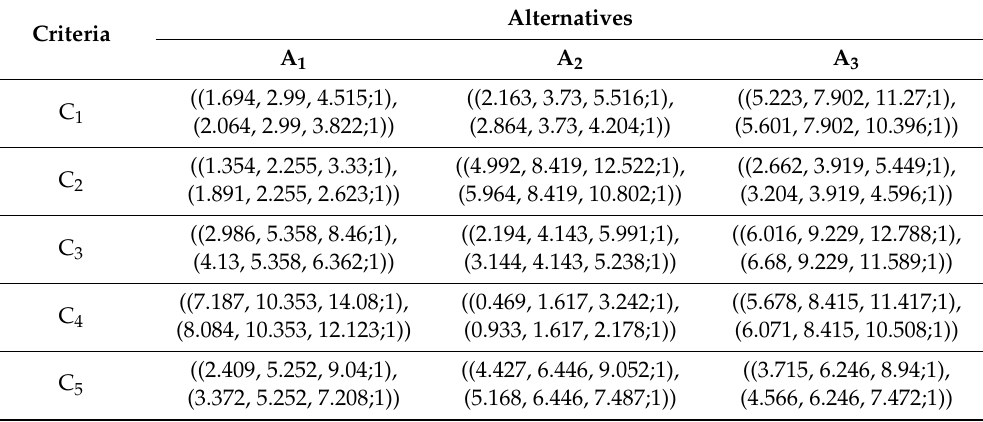
Table 7. Resulting decision matrix of the IT2F